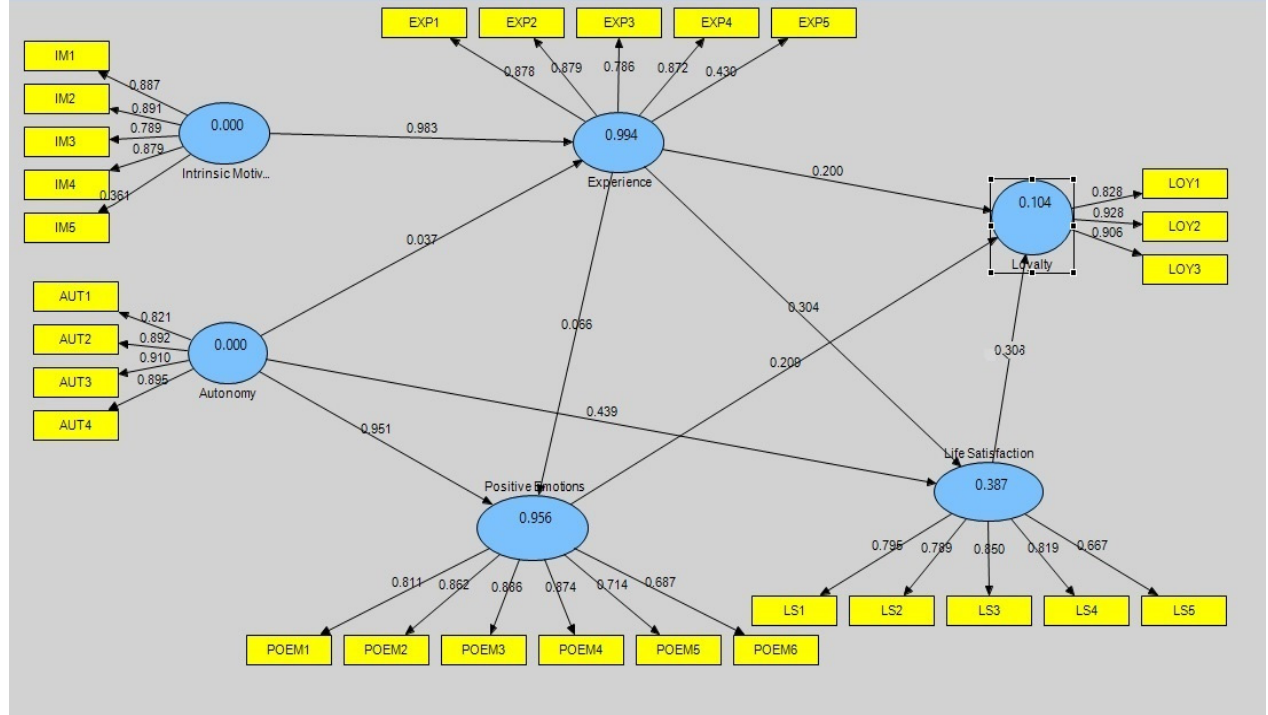
Figure 2. The estimated SEM path model. Source: Authors’ elaboration.